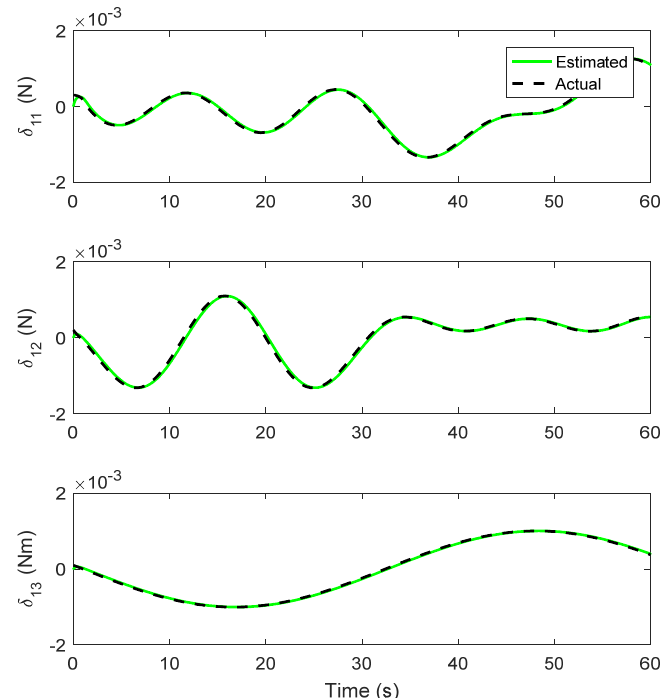
Figure 17. Mismatched lumped disturbance and estimation (Case 2).